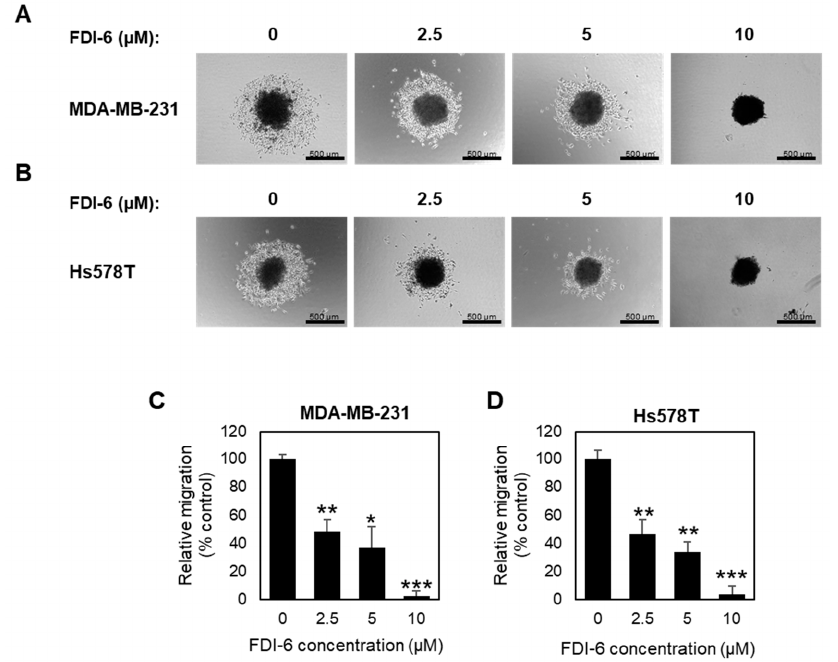
Figure 4. Effect of FDI-6 on the migration of TNBC cells in 3D spheroid assays. ( A , B ) Representative images of ( A ) MDA- MB-231 and ( B ) Hs578T spheroids after being treated with 0 µM, 2.5 µM, 5 µM, and 10 µM of FDI-6 for 72 h, after being transferred to a flat bottom culture plate and further incubated for 24 h. Scale bar = 500 µm; ( C , D ) The bar graphs represent the average of the relative migration of ( C ) MDA-MB-231 cells and ( D ) Hs578T cells in comparison with the control from three independent experiments ± S.D. ( n = 3). Statistical significance was determined by Student’s t-test (significant; * p < 0.05, ** p < 0.01, *** p < 0.001).